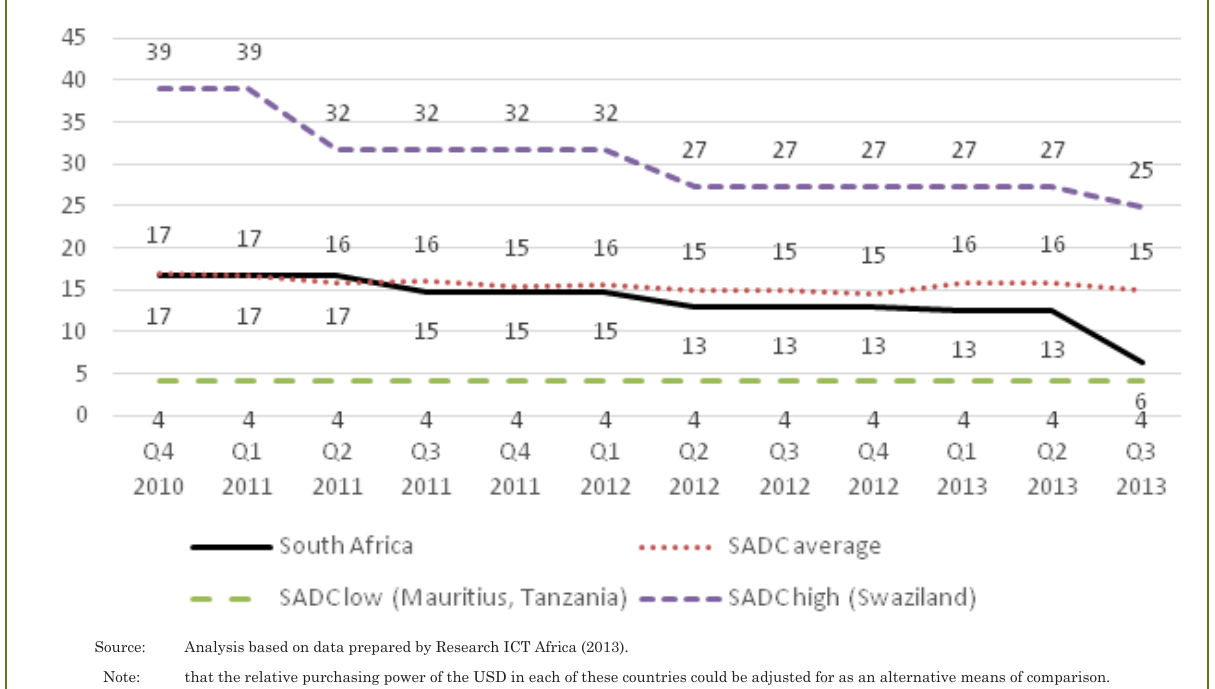
Source: Analysis based on data prepared by Research ICT Africa